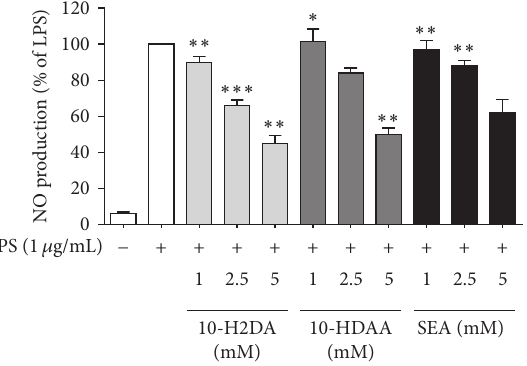
Figure 3: Effects of 10-H2DA, 10-HDAA, and SEA on LPS- induced NO production in RAW 264.7 cells. Cells were pretreated with/without indicated concentrations of 10-H2DA, 10-HDAA, and SEA for 1h and then stimulated with LPS (1 𝜇 g/mL) for 24 h. Control values were obtained in the absence of LPS and the three fatty acids. The values are presented as percentages of NO in comparison with LPS-treated cells. The data are the means ± SEMs for three independent experiments. Individual groups were compared by Student’s t -test ( ∗ 𝑃 < 0.05 , ∗∗ 𝑃 < 0.01 , and ∗∗∗ 𝑃 < 0.001 compared with the LPS